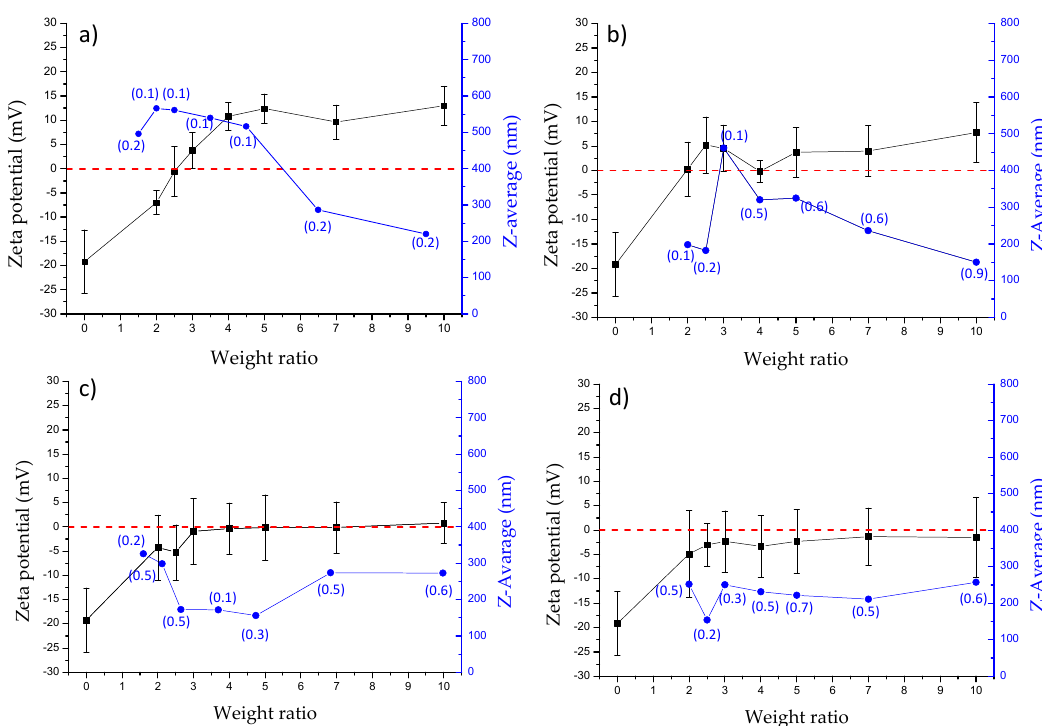
Figure 11. Mean size (blue line), PDI (value enclosed in brakets) and potential (black line) of polyplexes formed by siRNA and: ( a ) PHEA ‐ g ‐ bAPAE; ( b ) PHEA ‐ g ‐ PEG(A) ‐ g ‐ bAPAE; ( c ) PHEA ‐ g ‐ PEG(B) ‐ g ‐ bAPAE; ( d ) PHEA ‐ g ‐ PEG(C) ‐ g ‐ bAPAE graft copolymers, at weight ratios (R) ranging between 0 and 10 (data are reported as means SD, n = 3).